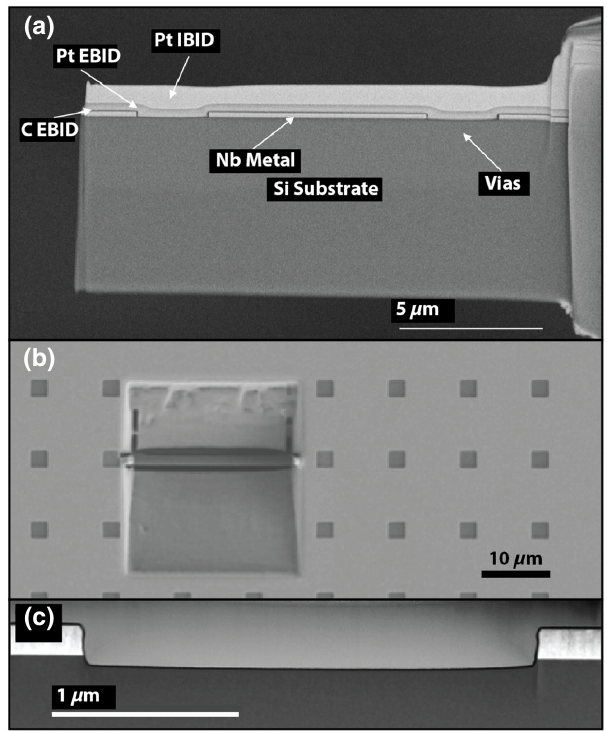
FIG. 9. (a) A SEM image of a TEM cross-section sample pre- pared by focused-ion-beam (FIB) liftout. The sample lamella are 30–60 nm thick. The sample is protected by an electron- beam-induced deposition (EBID) carbon layer deposited in situ , followed by EBID and ion-beam-induced deposition (IBID) Pt layers to protect the sample from Ga + ions during